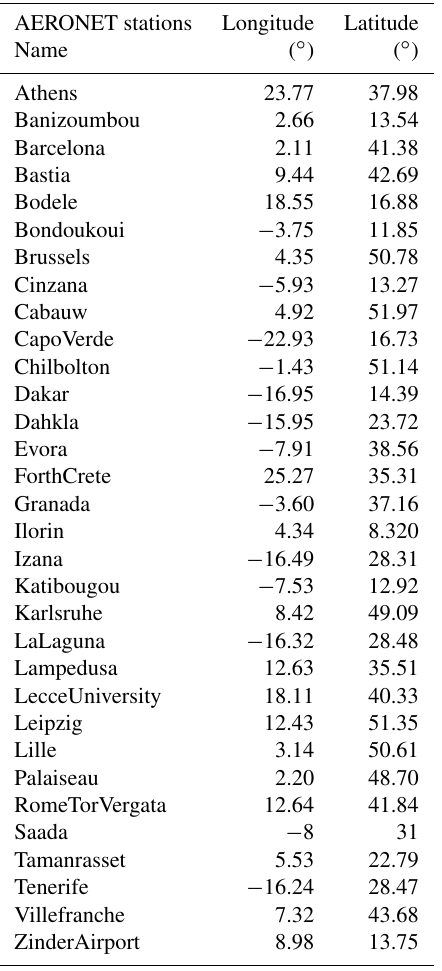
Table A1. List of the AERONET sites for the AOD measurements.